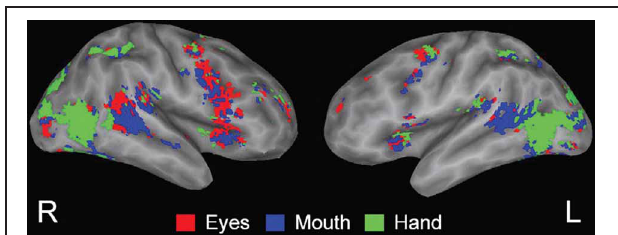
FIGURE 4 | From Pelphrey et al. (2005); Figure 3. fMRI activation related to viewing dynamic gestures; figures show activation from the condition showing the greatest response at each voxel (dark gray, sulcal depth; white, gyral crown). Red—the greatest response to Eyes, blue—Mouth, and green—Hand. Reprinted with permission from Pelphrey et al. (2005). © The Author